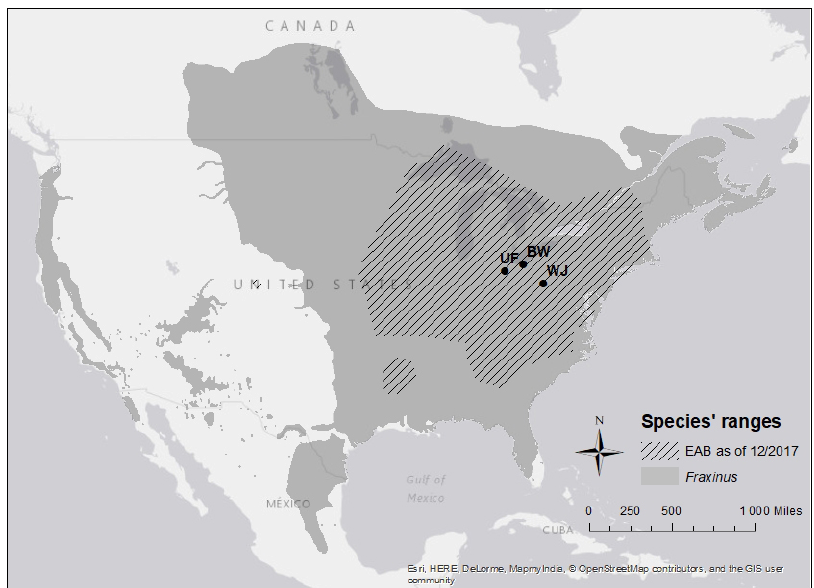
Figure 1. Current distribution of Fraxinus spp. (shaded region) and emerald ash borer (EAB, Agrilus planipennis , hatched region) in North America. Study sites are indicated on the map: UF, University of Findlay, Findlay, Ohio; BW, Baldwin-Wallace University, Berea, Ohio; and WJ, Washington & Jefferson College, Washington, Pennsylvania. Known EAB distribution as of 1 December 2017 [33].